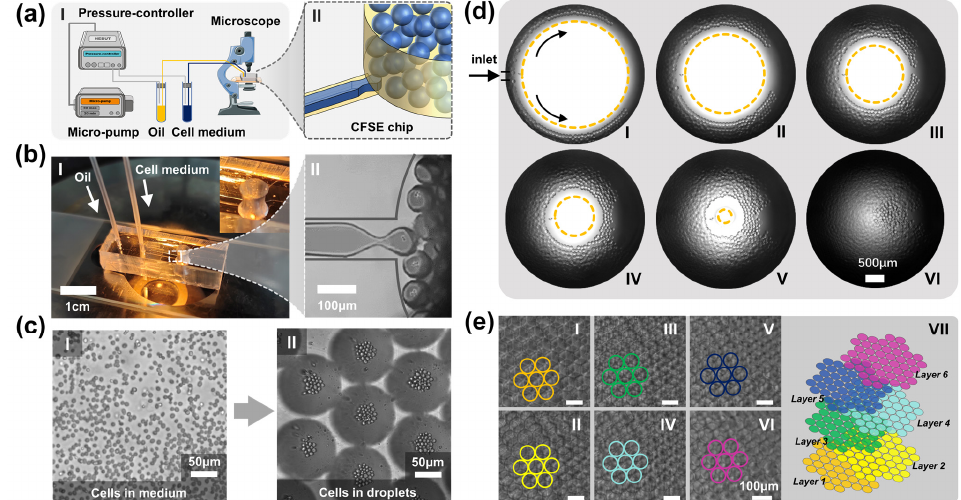
Figure 3. CFSE-based droplet generation. ( a ) Schematic of the 3D cell culture system. I: The system consists of a micropump, pressure controller, fluid tubes, CFSE chip, and inverted microscope; II: Schematic diagram of the “co-flow step emulsification”. ( b ) Optical photograph of the microfluidic CFSE device. I: Cell medium and oil were pumped into the microchannels; II: The cell medium broke into emulsion droplets. ( c ) Cell clusters in medium (I) and in droplets (II). ( d ) The resulting droplets bulk the cylindrical reservoir within several minutes with an ultra-high-volume fraction ( φ = 72%, Q inner-phase = 1.28 μ L/min, Q outer-phase = 0.49 μ L/min, Φ = 80.38 ± 2.18 μ m). I–VI shows the droplet perfusion process in the cylindrical storage reservoir in 30 seconds. ( e ) The close-packed droplet arrays arrange themselves in a hexagonal pattern. I–VI demonstrate the droplet arrays of six layers arranged from top to bottom. VII demonstrates the stacked status of the droplet arrays.